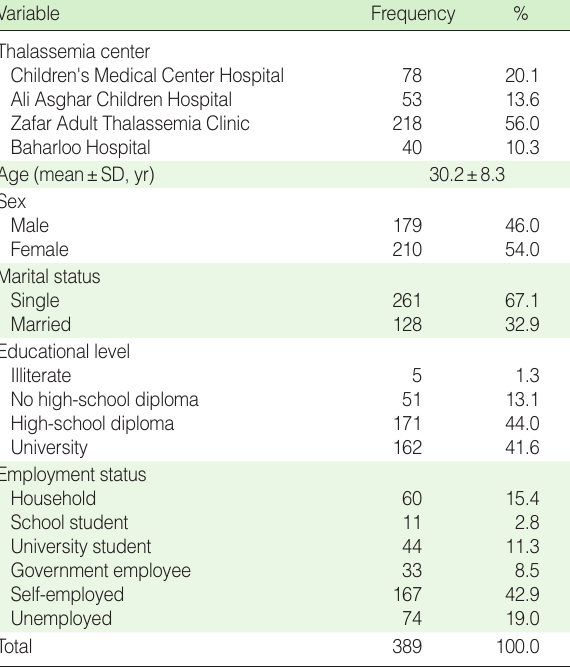
Table 1. Demographic characteristics of the study participants